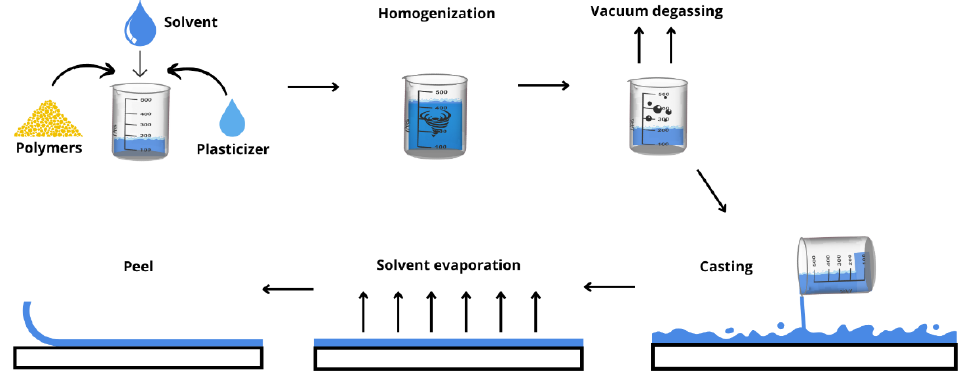
Figure 8. Scheme of the production, in a small scale, of a polymeric film using the solvent casting technique.